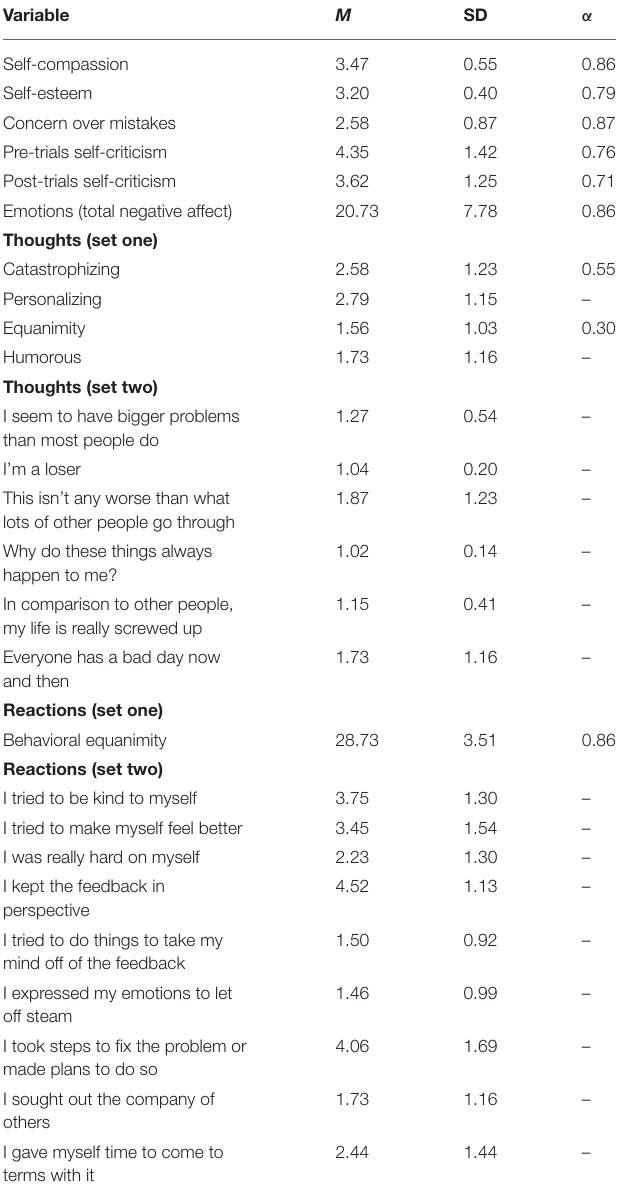
TABLE 2 | Descriptive statistics and internal reliabilities of psychological scales and subscales for Phase II participants.